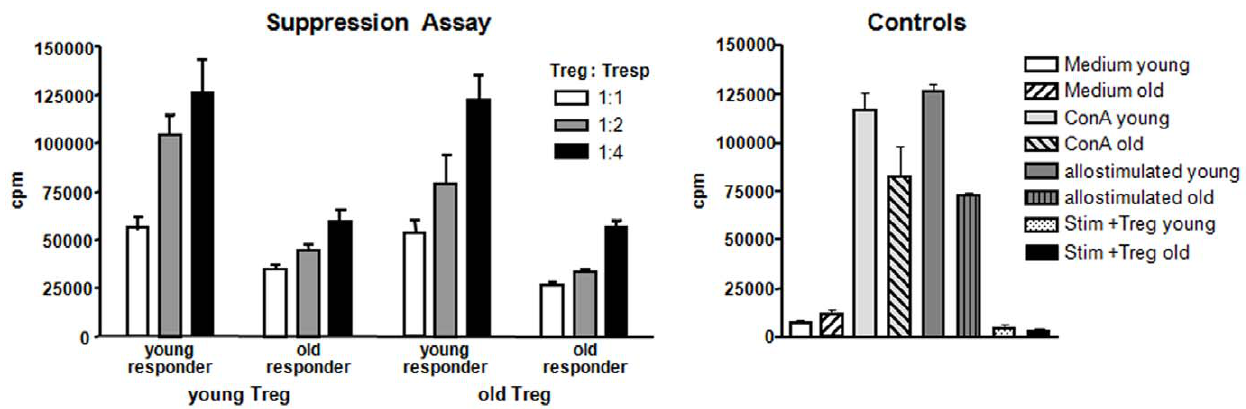
Figure 6. Regulatory T-cell function remains unaltered with age. Regulatory T-cell function remains age-independent: CD4 + CD25 2 T-cells (responder cells) and regulatory T-cells (FoxP3 + ) were co-cultured at different ratios in the presence of stimulator cells. The proliferation of responder cells was determined by Thymidine incorporation. Young and old Tregs suppressed the proliferation of responder cells in a dose-dependent manner. Co-culture of old Tregs with young responders cells demonstrated a well-preserved suppressor function of old regulatory T-cells comparable to the suppressor function of young regulatory T-cells.